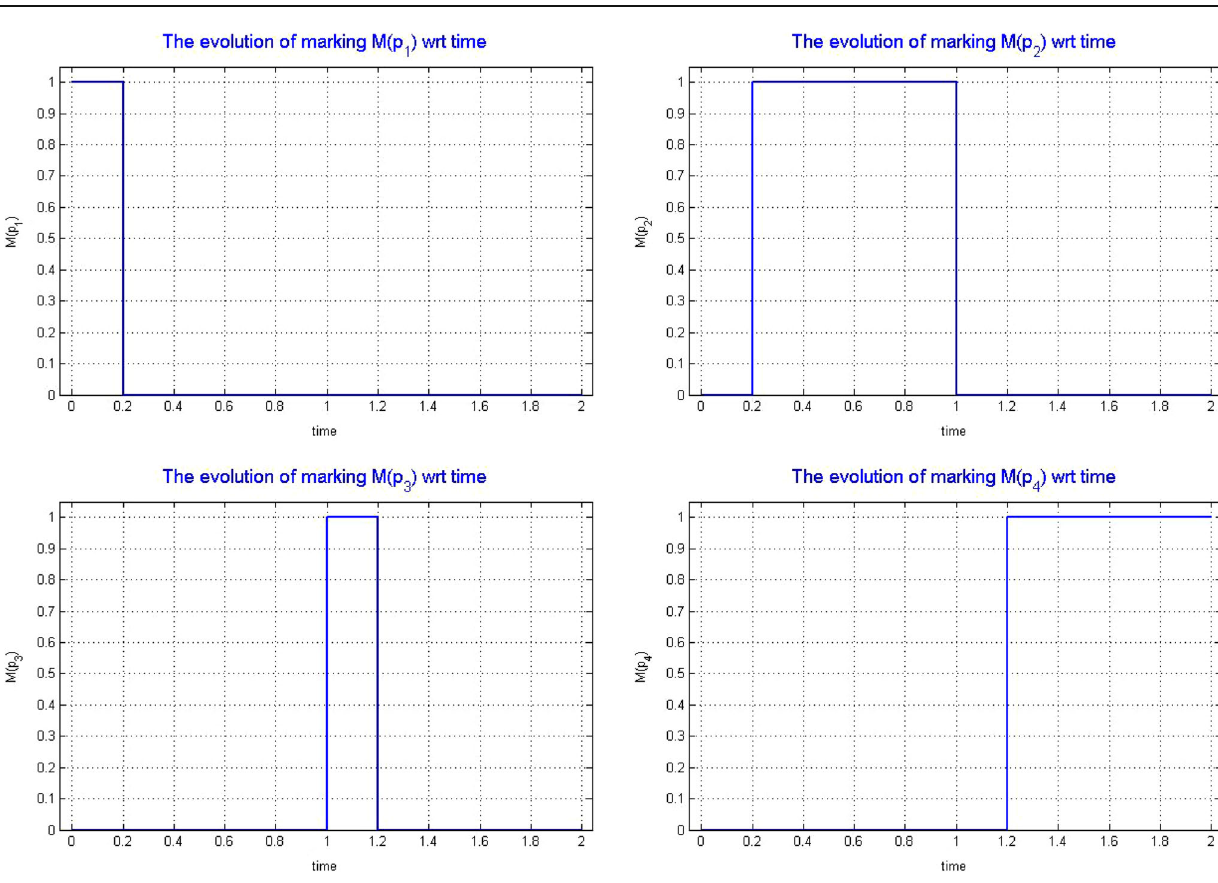
Fig. 10 The courses of marking the places p 1 − p 4 wrt. (with respect to)